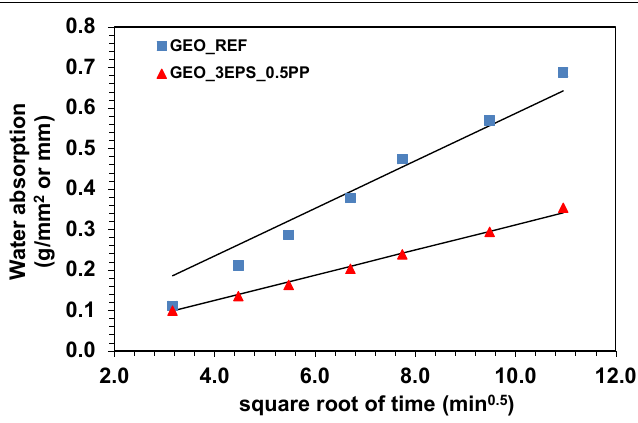
Figure 12. Association between water absorption per unit area and square root of time. Table 6. Sorptivity and R 2 values of tested geopolymers.